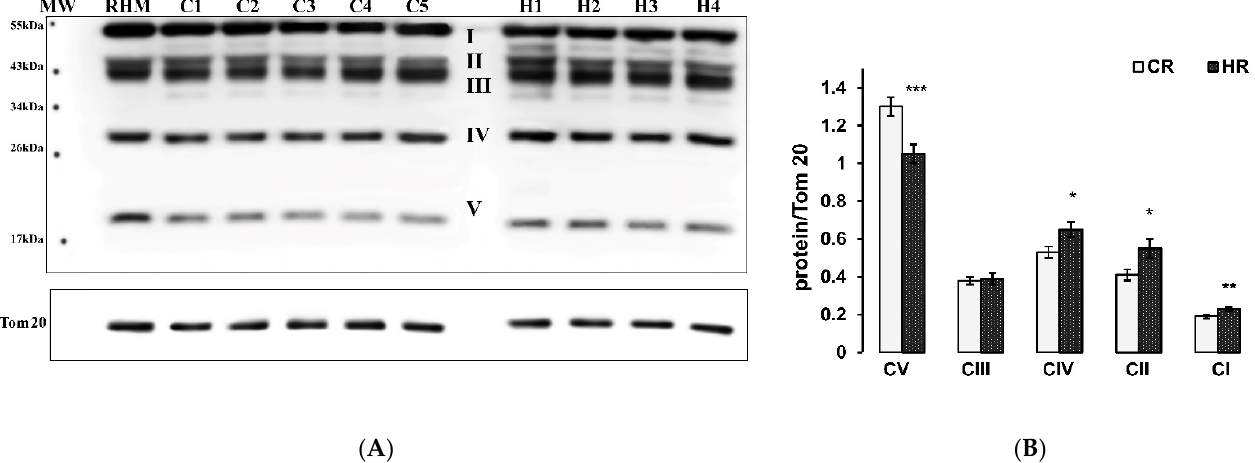
Figure 2. Level of representative subunits of the complexes in control and hyperthyroid rats. ( A ). Representative Western blot of OXPHOS subunits (I-ATP5A (CV), II-UQCRC2 (CIII), III-MTCO1 (CIV), IV-SDHB (CII) and V-NDUFB8 (CI)) was detected in isolated heart mitochondria (10 µg of protein/lane) by using the Total OXPHOS Rodent WB Antibody Cocktail. HRM-rat heart mitochondria western blot control, C1-C5-heart mitochondria from the control rats; H1-H4-heart mitochondria from the hyperthyroid rats. ( B ). Bar graphs represent the levels of appropriate complexes with respect to the Tom 20 level in absolute units. CR-control, HR-hyperthyroidism * p < 0.05, ** p < 0.02, *** p < 0.001 compared with the corresponding control data ( n = 15 in each group).